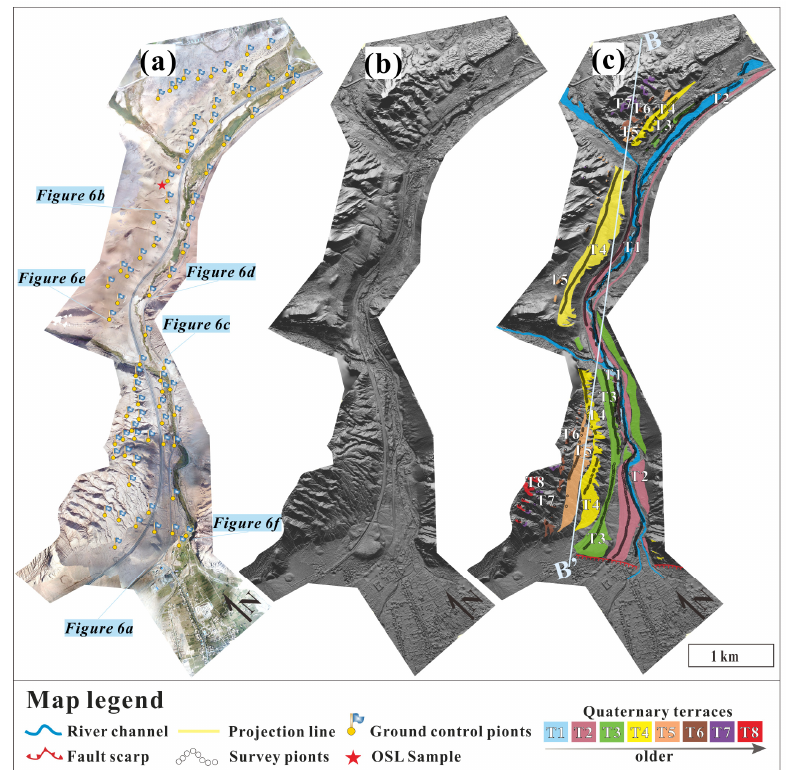
Figure 5. ( a ) Orthography imaging of the Shengjingou Valley (location in Figure 2b). Blue flags represent the surveyed ground control points. Red stars represent the location of OSL sample. ( b ) High-resolution DEM surveyed by UVA. ( c ) DEM shaded topography showing the locations of terraces identified in the Shengjingou Valley. Colors and numbers represent different terrace generations, and black hollow dots show survey points on terraces and river